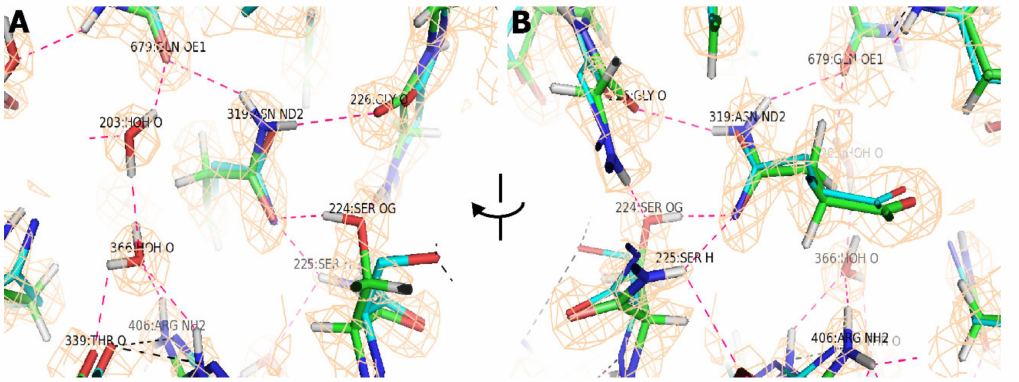
Figure 5. The hydrogen bond network near Asn 319 defined at high resolution. Panels ( A ) and ( B ) are forward and reverse views of the same region, rotated about the vertical axis shown. The atomic models at 2.8 Å and 1.56 Å are shown with cyan and green carbons, respectively, overlaid on the 1.56 Å resolution map, contoured at 1.5 σ . The network of 12 hydrogen bonds implicated at 1.56 Å (pink dashes) is completely di ff erent from the 3 suggested at 2.8 Å (black dashes). There are three principle causes: (1) the water molecules bridging between Gln 679 and Thr 339 / Arg 406 of a neighboring subunit are apparent only at the higher resolution. Solvent hydrogen locations are not apparent in the map and were oriented by energy minimization. (2) At 2.8 Å, an incorrect rotamer was chosen for Asn 319 , with χ 2 flipped by 180 ◦ . Even at 1.56 Å, the map gives little indication, but the changed rotamer has superior interactions with Gln 679 and Ser 224 -Gly 226 . (3) There were two reasons that the latter were not recognized: (a) the O γ of Ser 225 was misplaced by 2 Å, with the correct rotamer only apparent at 1.56 Å; (b) The backbone for Ser 224 -Gly 226 di ff ers by 0.52 Å. In the 1.56 Å resolution map, both the carbonyl oxygen of Gly 226 and the amino hydrogen of Ser 225 are clear (see reverse view, panel ( B )) in the map contoured at 1.5 σ , confirming the